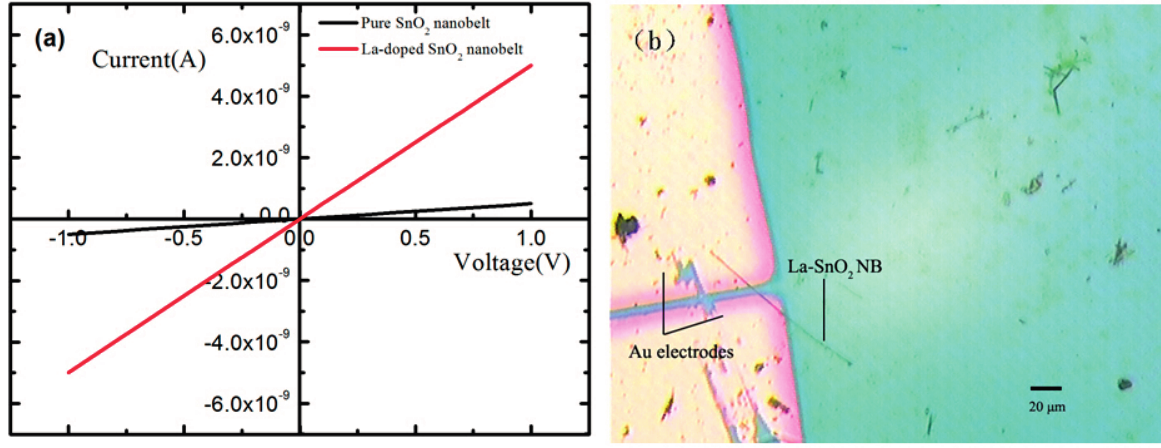
Figure 4. ( a ) The I–V curves of pure SnO 2 NB and La-SnO 2 NB devices; ( b ) The optical microscope image of a prepared La-SnO 2 NB